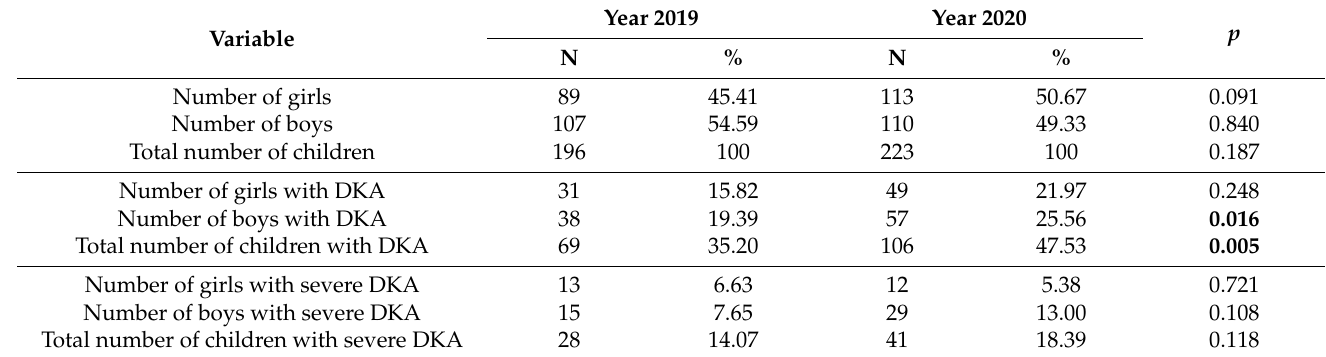
Table 1. Characteristics of children and the prevalence of diabetic ketoacidosis in 2019 and 2020 with an independence assessment by a chi-square test.